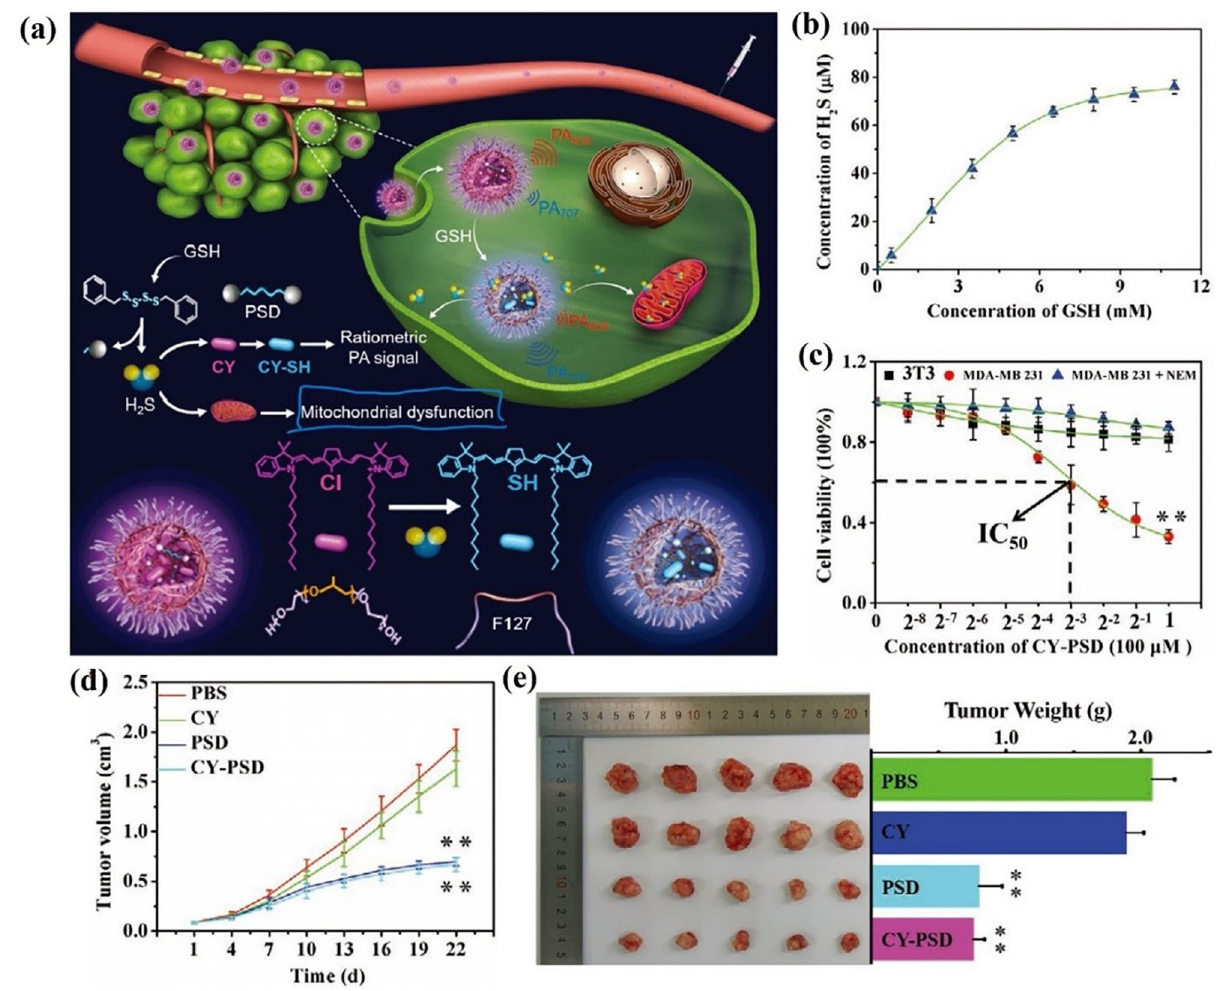
Figure 2: ( a ) Schematic illustration of PA monitored thiol - induced H 2 S therapy for triple - negative breast cancer. ( b ) Yielded H 2 S concen - tration from the interaction between PSD ( 50 × 10 − 6 M ) and GSH ( 0 – 11 × 10 − 3 M ) . ( c ) Concentration – response curves of cell viability of CY - PSD nanoparticles - incubated 3T3 ( square ) , MDA - MB 231 ( dot ) , and NEM - pretreated MDA - MB 231 ( triangle ) cells. ( d ) Tumor volume change curves of MDA - MB 231 tumor - bearing mice after injecting various materials ( CY nanoparticles, CY - PSD nanoparticles, and PSD nanopar - ticles ) and with phosphate - bu ff ered saline ( PBS ) controlled. ( e ) Tumor sizes and weights from each treatment group. Reprinted with permission from ref. [ 32 ] . Copyright © 2020 Wiley -